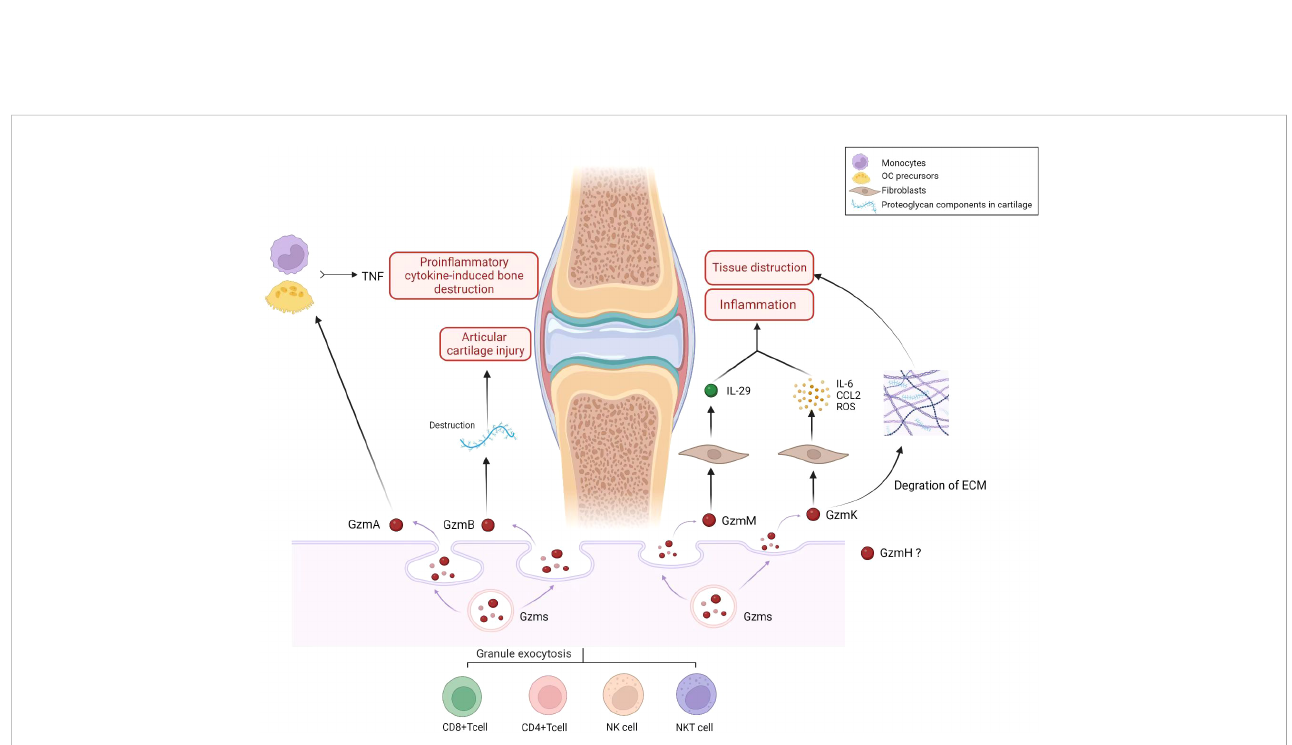
FIGURE 1 Role of Granzyme family (GzmA, GzmB, GzmH, GzmM, GzmK) in pathology and progression of RA. Gzms are produced and released by immune cells, such as cytotoxic T cells and natural killer cells. They play a role in the ability of the immune system to recognize and eliminate infected or damaged cells. The granzyme family includes several granzyme types, including granzyme A (GzmA), granzyme B (GzmB), granzyme H (GzmH), granzyme M (GzmM), and granzyme K (GzmK). In the context of RA, Gzms may contribute to the pathology and progression of the disease in several ways. RA is an autoimmune disorder characterized by chronic in fl ammation of the joints that leads to joint damage and deformity. Gzms may contribute to the in fl ammation and joint damage observed in RA by inducing programmed cell death (apoptosis) in cells within the joint tissue. This can lead to the destruction of joint cartilage and bone, resulting in joint deformity and loss of function. As the fi gure shows, GzmA activates monocytes and other OC precursors to secrete TNF, thus increasing proin fl ammatory cytokine-induced bone destruction observed in RA. GzmB can degrade proteoglycan components in cartilage and contribute to the destruction of articular cartilage in RA. GzmM plays a role in the pathophysiology of RA by stimulating the release of proin fl ammatory cytokine IL-29. GzmK induces synovial fi broblasts to activate proin fl ammatory pathways, including IL-6, CCL2, and ROS production. The protease activity of GzmK can also promote degradation of the ECM, leading to in fl ammatory cell in fi ltration and tissue destruction. (Created with BioRender.com).